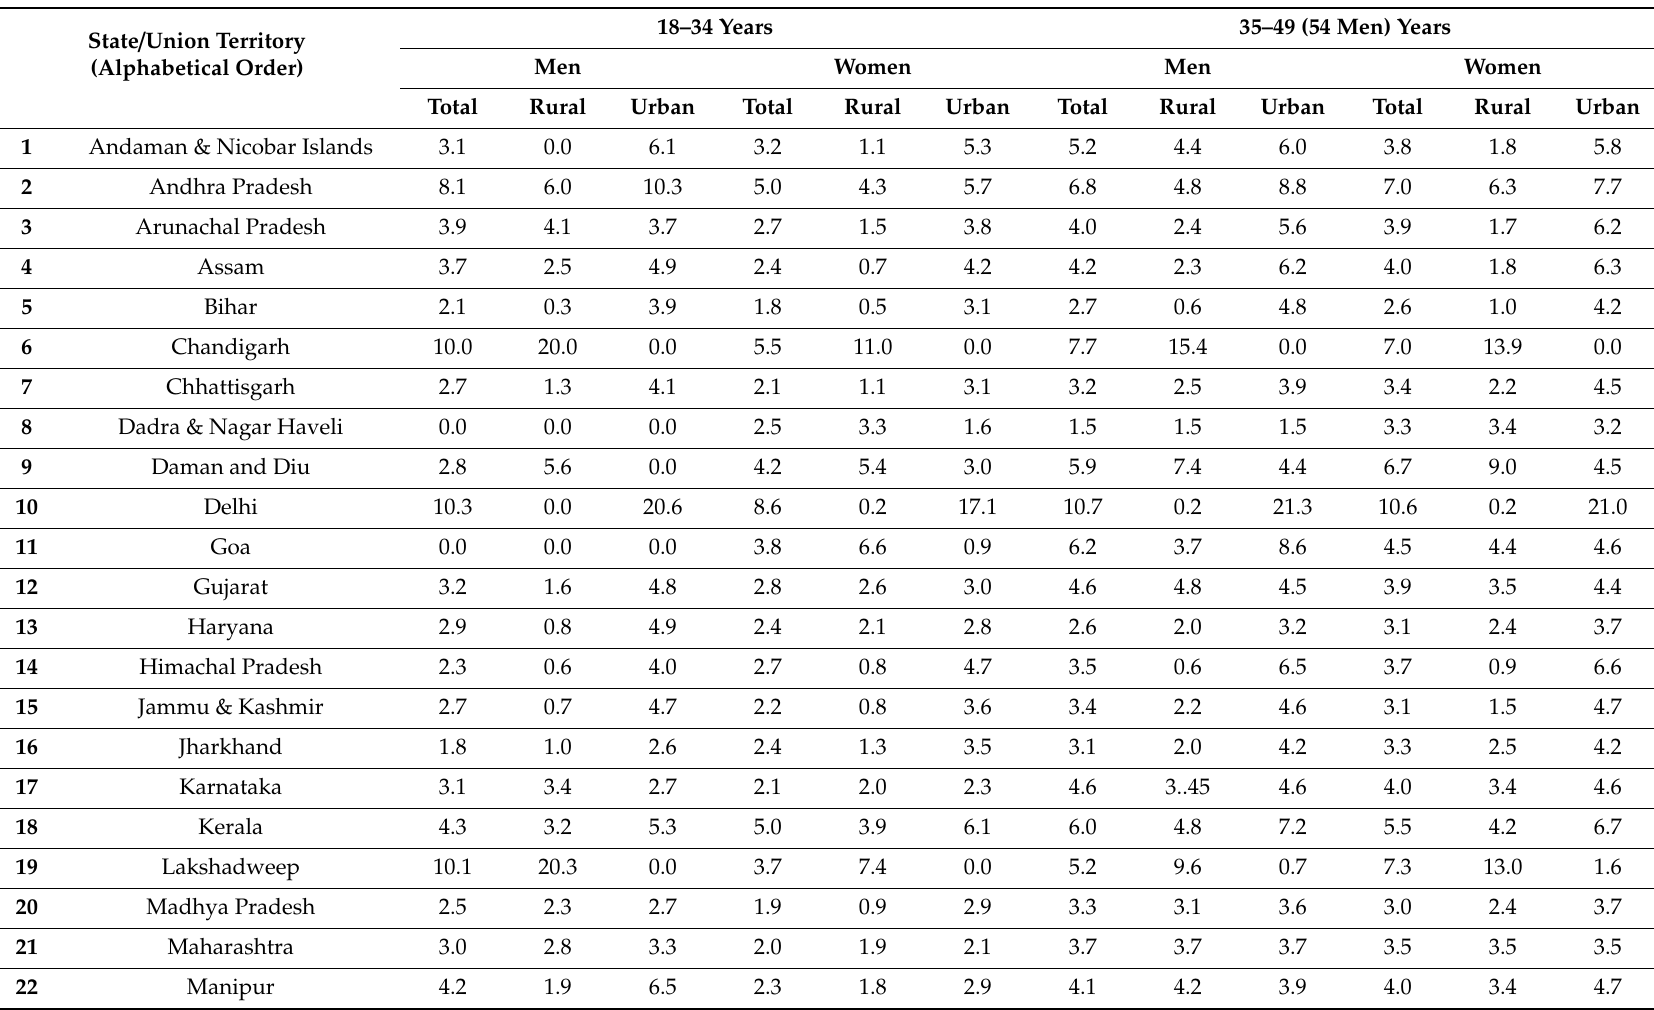
Table 5. The prevalence of diabetes among adults according to age group, sex, and type of residence for each state and union territory. State / Union